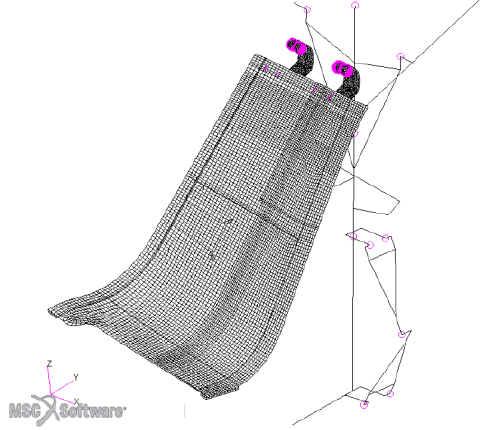
Figure 4. MLG door architecture.